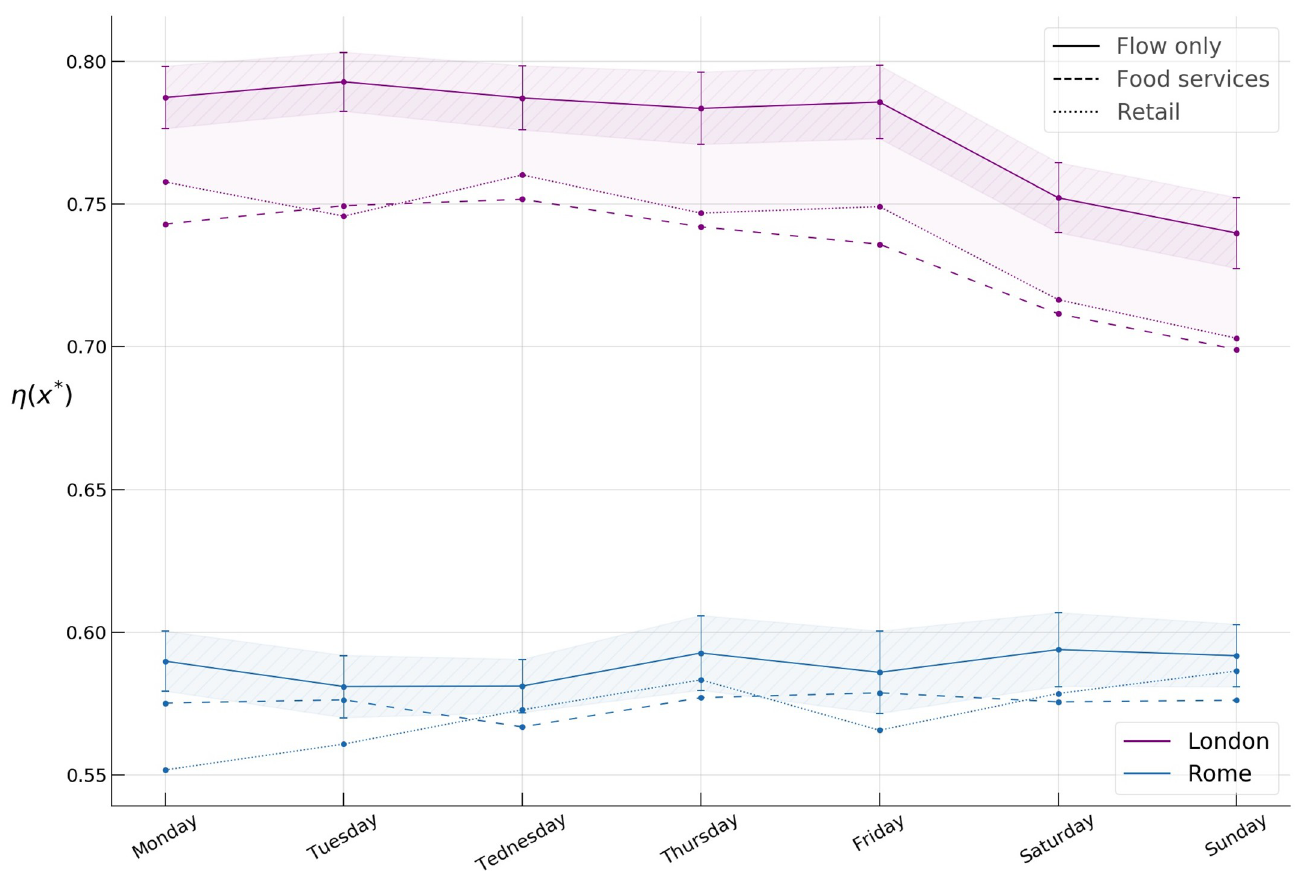
Fig 12. Spreading indices for flow only, food services, and retail activity in Rome and London during the week.